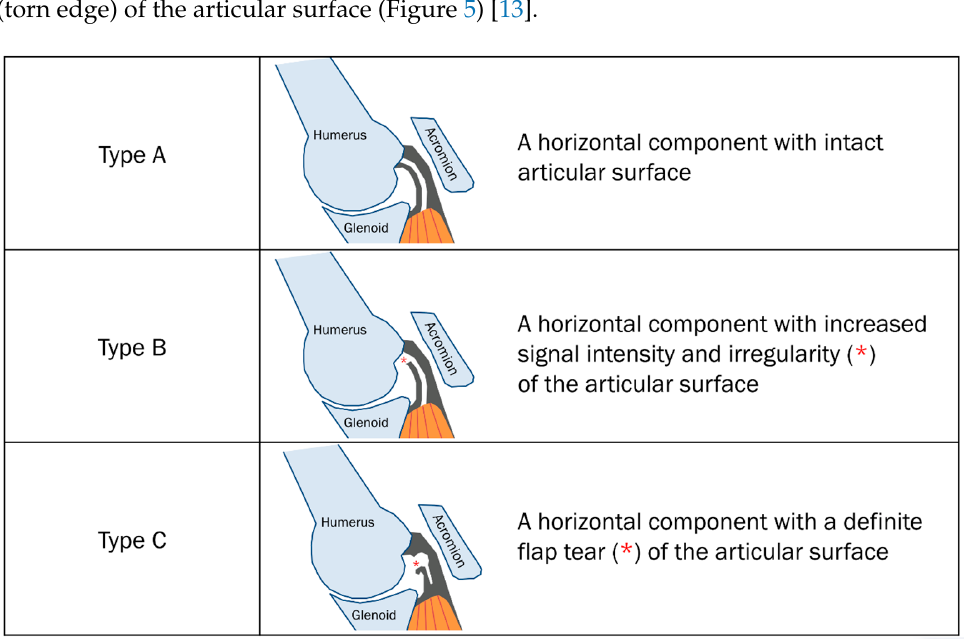
Table 1. Delaminated tear of partial-thickness tear by Lee et al. [13].